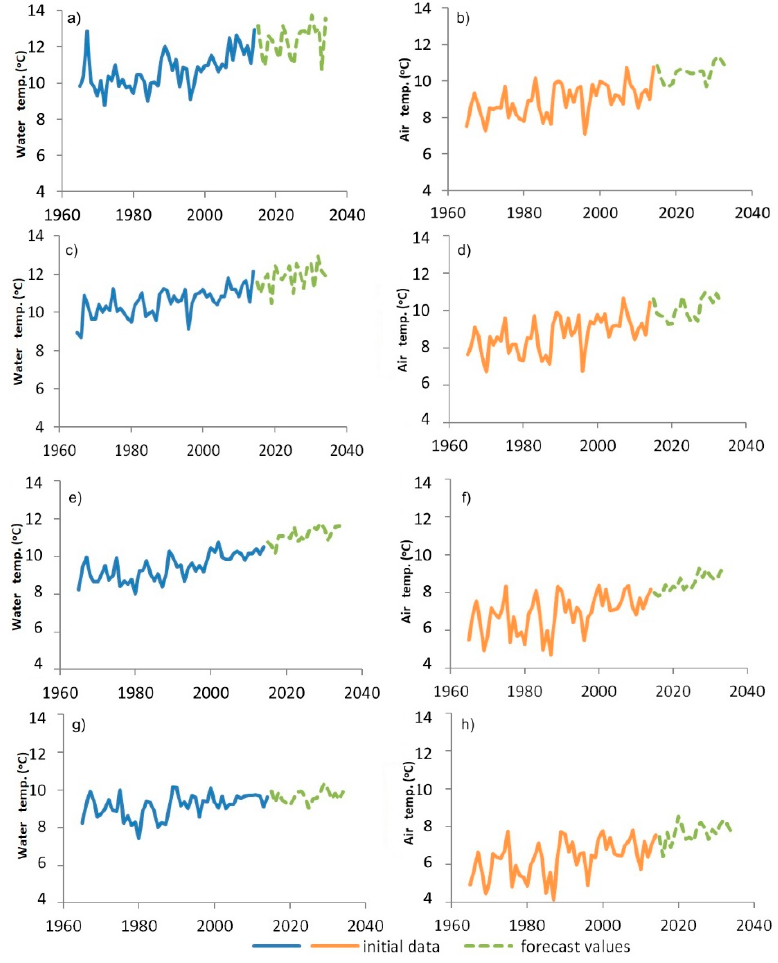
Figure 10. Predicted temperatures of water and air temperature for the Oder and Neman Rivers: ( a ) Odra (Brzeg), ( b ) Opole, ( c ) Odra (S ł ubice), ( d ) Gorzów Wlkp, ( e ) Niemen (Grodno), ( f ) Grodno, ( g ) Niemen (Smalininkai), ( h ) Raseiniai (±90% confidence interval).